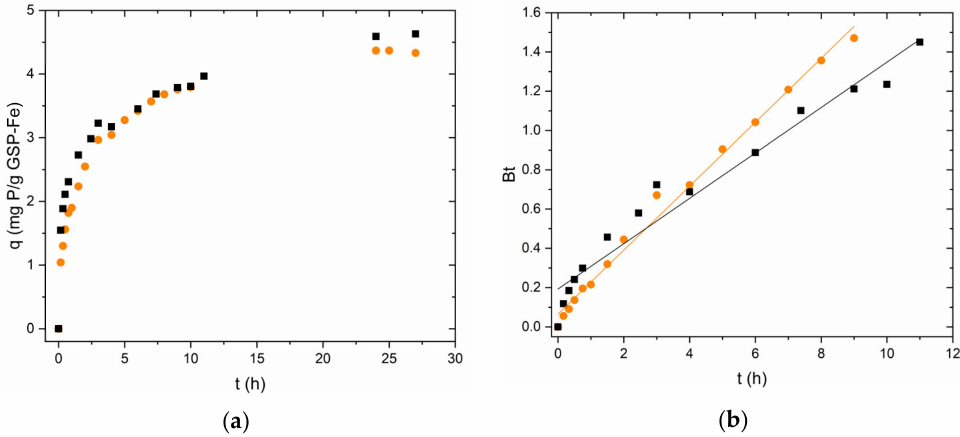
Figure 6. ( a ) Phosphorus adsorption kinetics using GSP-Fe S-1 ( • , initial P concentration 33 mg · L − 1 ) and S-0.5 ( (cid:4) , initial P concentration 33 mg · L − 1 ). ( b ) Application of Boyd model to the phosphorus adsorption kinetics data. pH 2.1, room temperature and stirring at 175 rpm for all